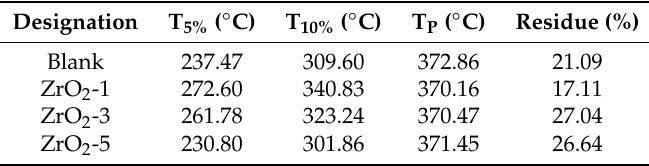
Figure 3. ( a ) Thermo Gravimetric Analysis (TGA) and ( b ) Derivative Thermogravimetric Analysis (DTGA) thermograms of PU / V-ZrO 2 nanocomposites at β = 5 ◦ C · min − 1 . Table 1. Thermal decomposition characteristics of PU / V-ZrO 2 nanocomposites derived from TGA diagrams at β = 5 ◦ C · min − 1